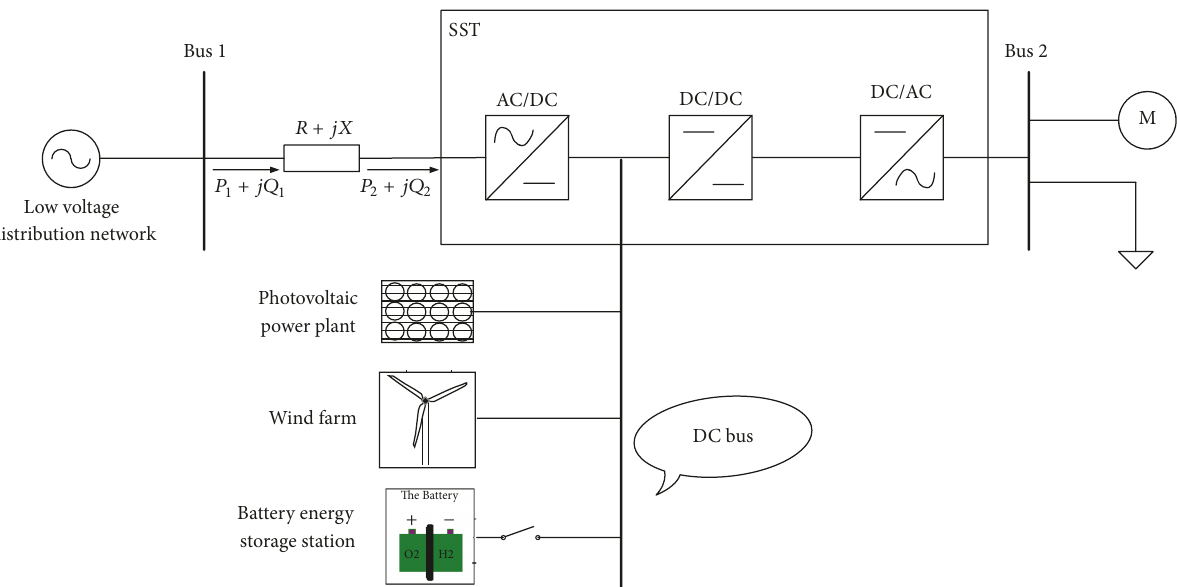
Figure 3: Model of low voltage distribution network integrated with DGs using